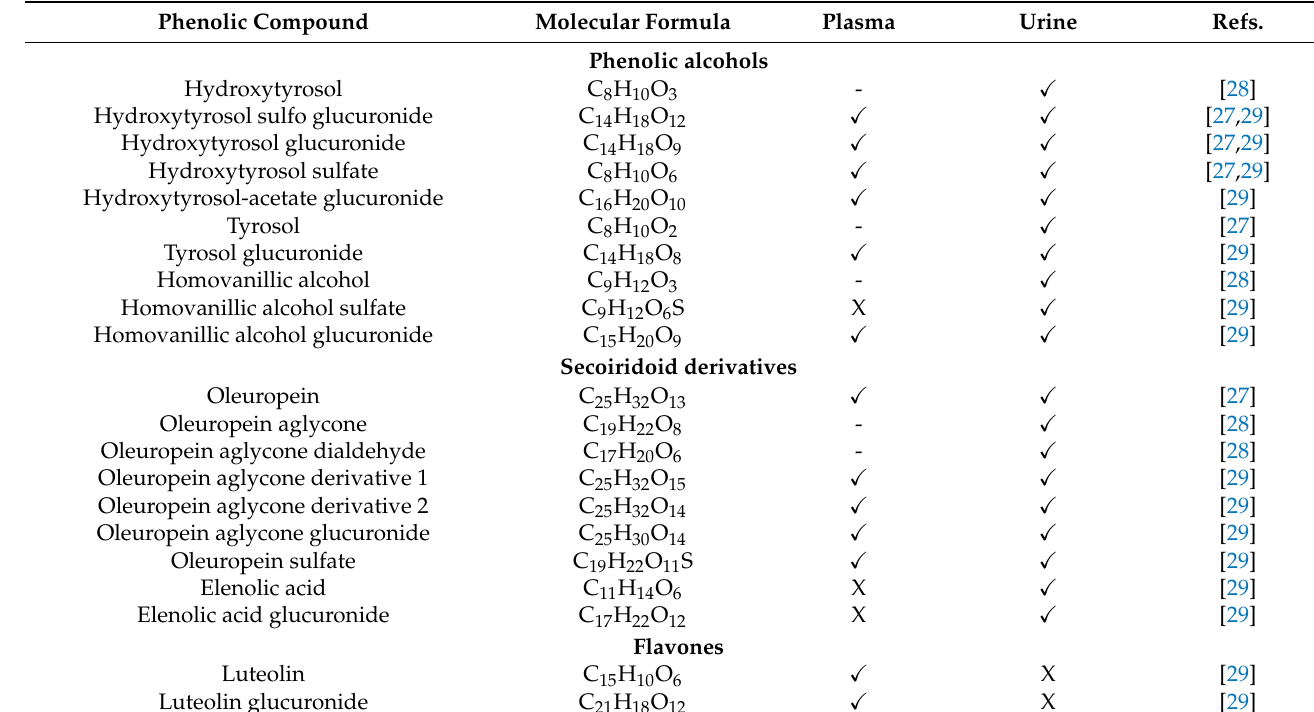
(cid:88) : indicates presence of the compound in the sample; X: indicates the absence of the compound in the sample; -: indicates the absence of evidence about the specific metabolite in the